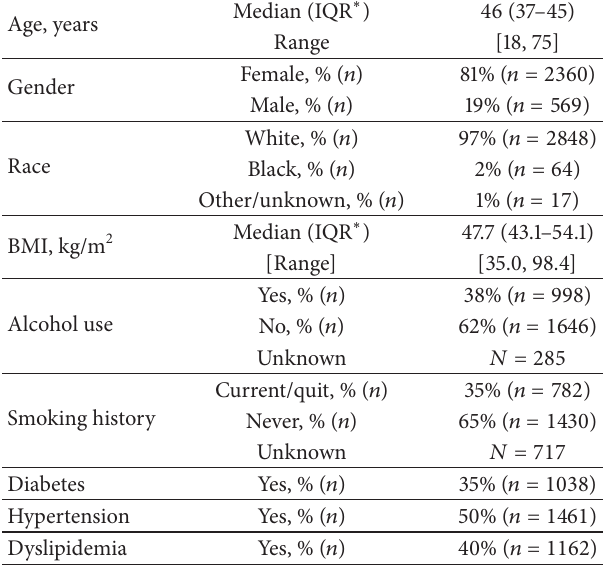
Table 1: The demographics of the 2929 patients who were included in the study population.